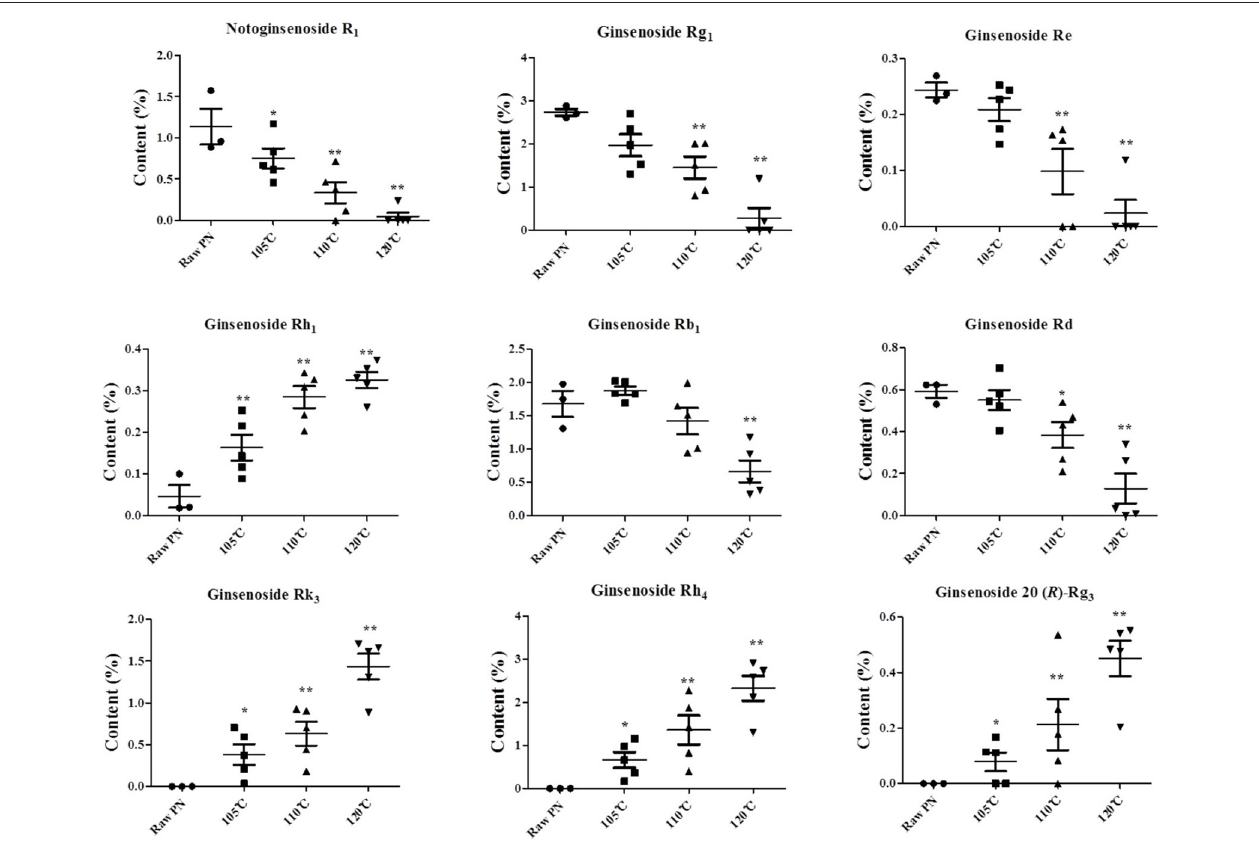
FIGURE 6 | The contents of notoginsenoside R 1 , ginsenosides Rg 1 , Re, Rh 1 , Rb 1 , Rd, Rk 3 , Rh 4 , and 20 ( R )-Rg 3 in raw and steamed Panax notoginseng (PN) roots at different steaming temperatures. The points on the scatter plots represent the quantities of the nine constituents in 18 batches of PN samples. Error bars represent